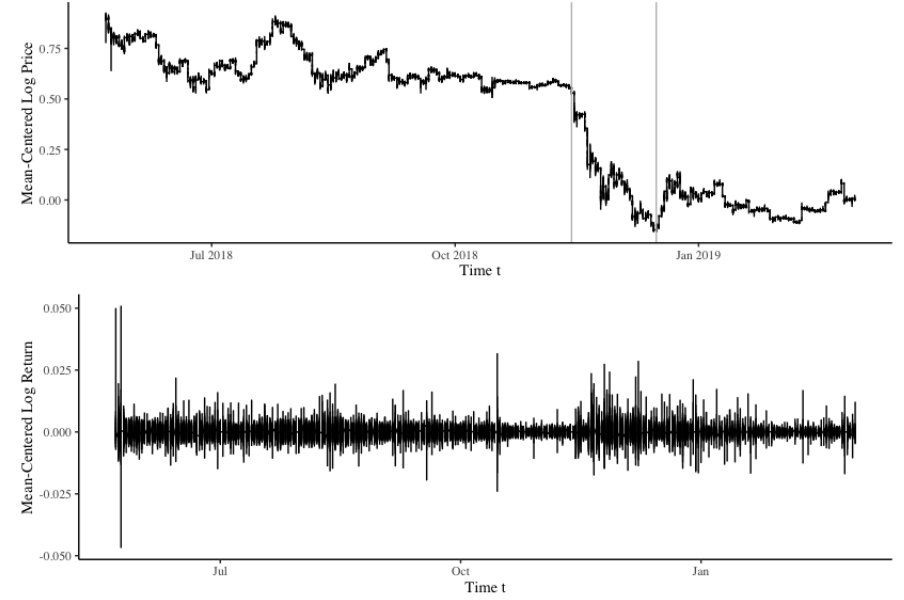
Figure 8. High frequency mean-centered log Bitcoin open price process ( top ) and mean-centered log returns process ( bottom